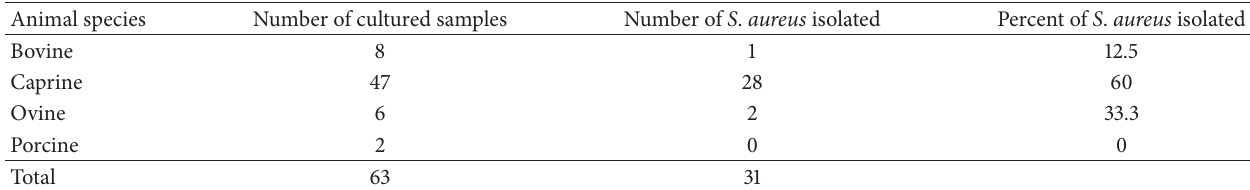
Table 2: Isolation rate of S . aureus from different food producing animal species.